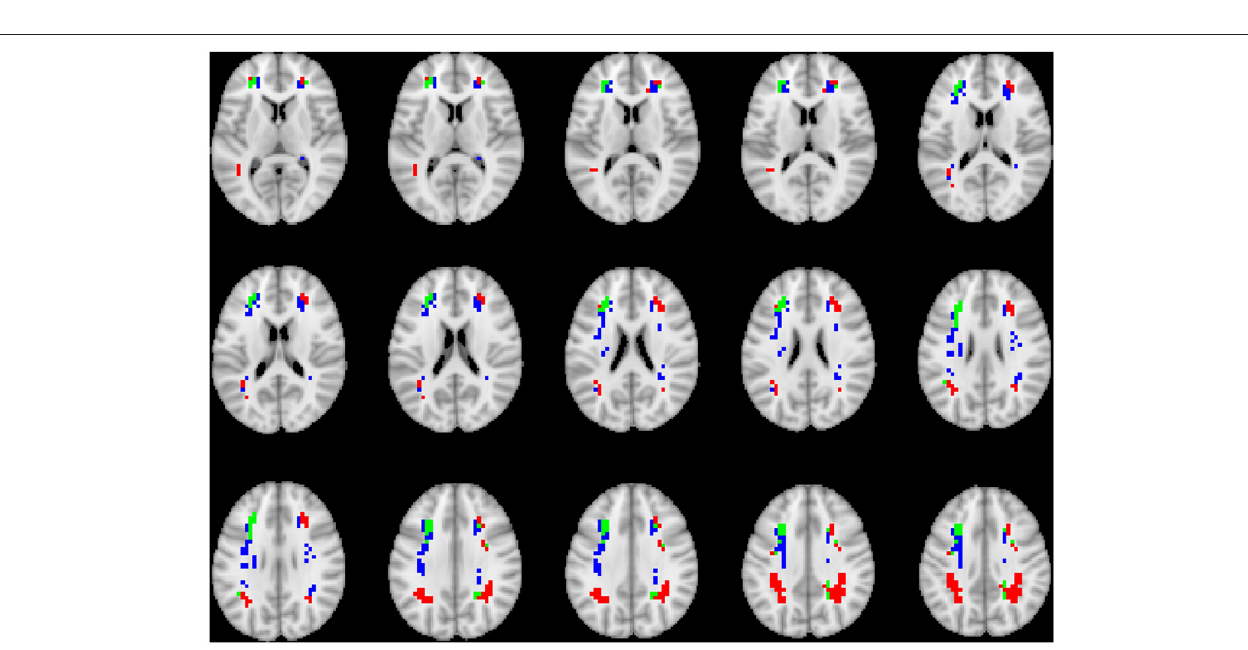
FIGURE 4 | Axial views of voxels primarily contributing to children classification in dMRI image. Green, common to DBD and TD groups; red, DBD group; blue, TD group. The right side of each image corresponds with the right side of the brain.